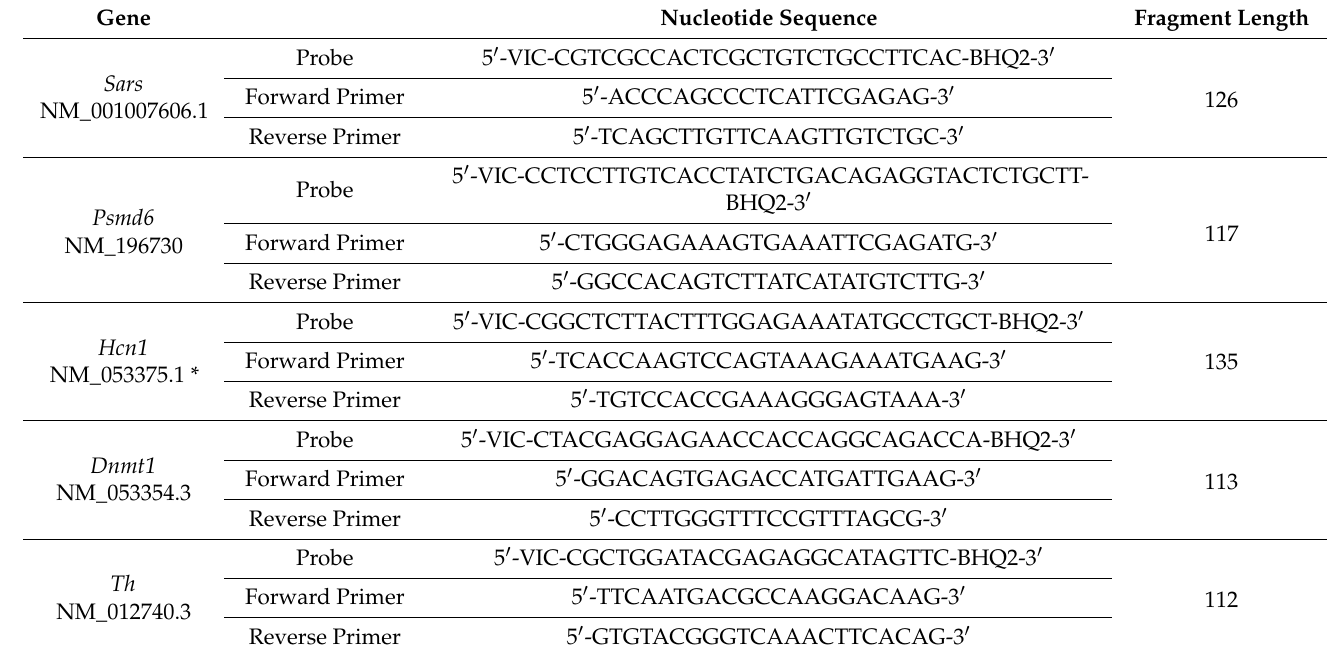
Table 1. Nucleotide sequences of gene-specific primers and